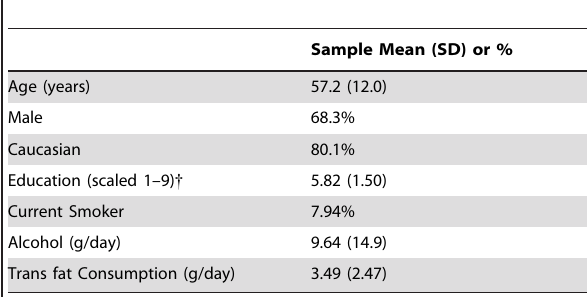
Table 1. Baseline Subject Characteristics (N